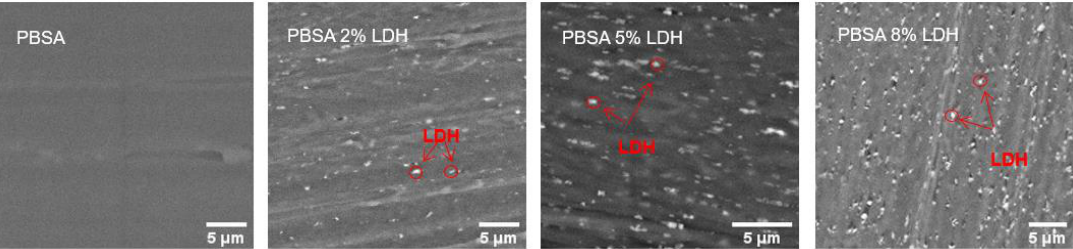
Figure 1. SEM images collected of PBSA and PBSA nanocomposite films with 2 wt%, 5 wt%, 8 wt% LDH demonstrating the dispersion of the LDH particles in the films.